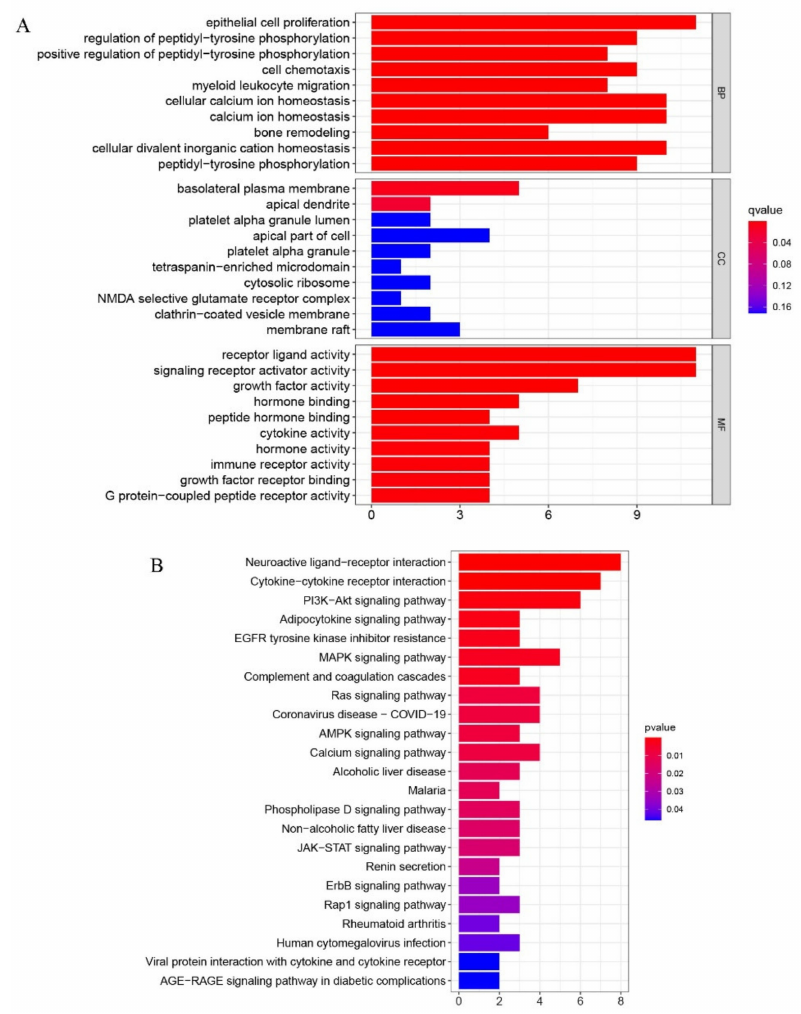
Figure 8. ( A ) Gene Ontology (GO) analyses were conducted to predict the potential function of the differentially expressing immunity related genes between the treat and the control group, including cellular component (CC), molecular function (MF), biological process (BP), respectively. ( B ) Kyoto En- cyclopedia of Genes and Genomes (KEGG) predicted potential pathways regarding the differentially immunity related genes between the treat and the control